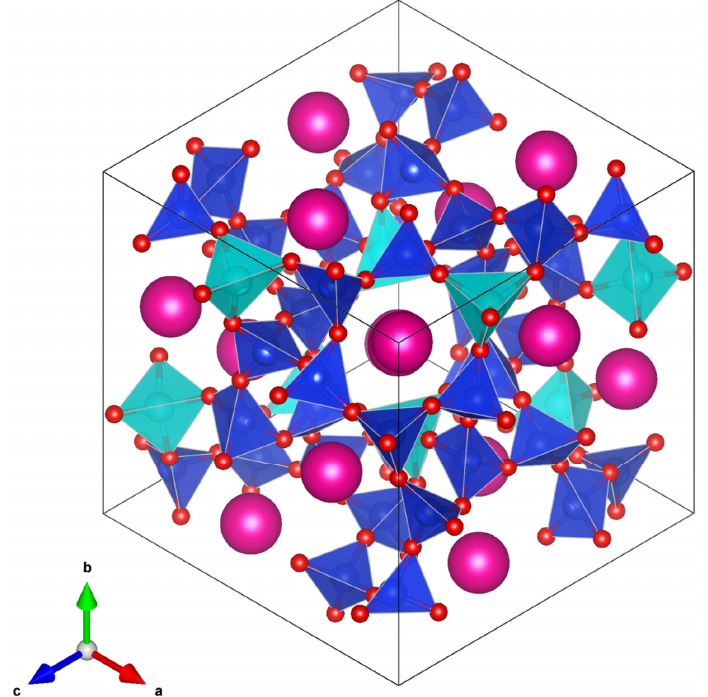
Figure 12. VESTA plot showing the 447 K (MgO calibrated temperature) Pbca orthorhombic crystal structure of Rb 2 CoSi 5 O l2 . Pink spheres represent Rb + cations, red spheres represent O 2 − anions, dark blue tetrahedra represent SiO 4 units and light blue tetrahedra represent CoO 4 units.